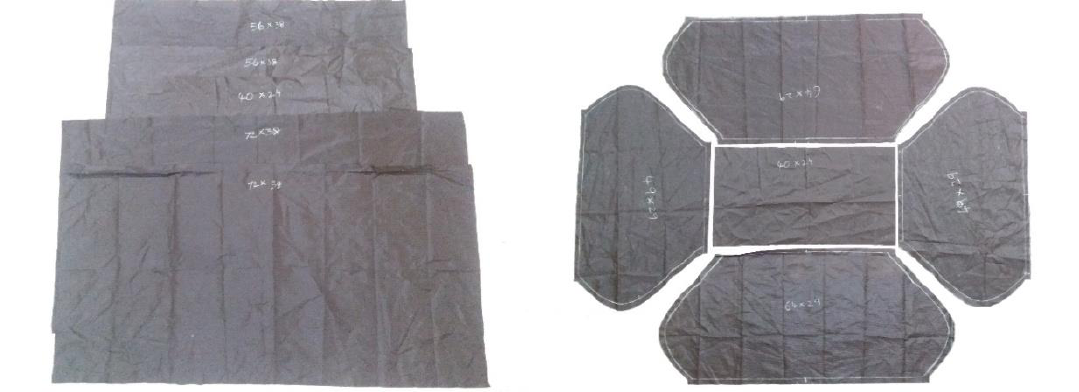
Figure 8. Material used for fabrication of skirt Figure 9. Skirt panels before sewing